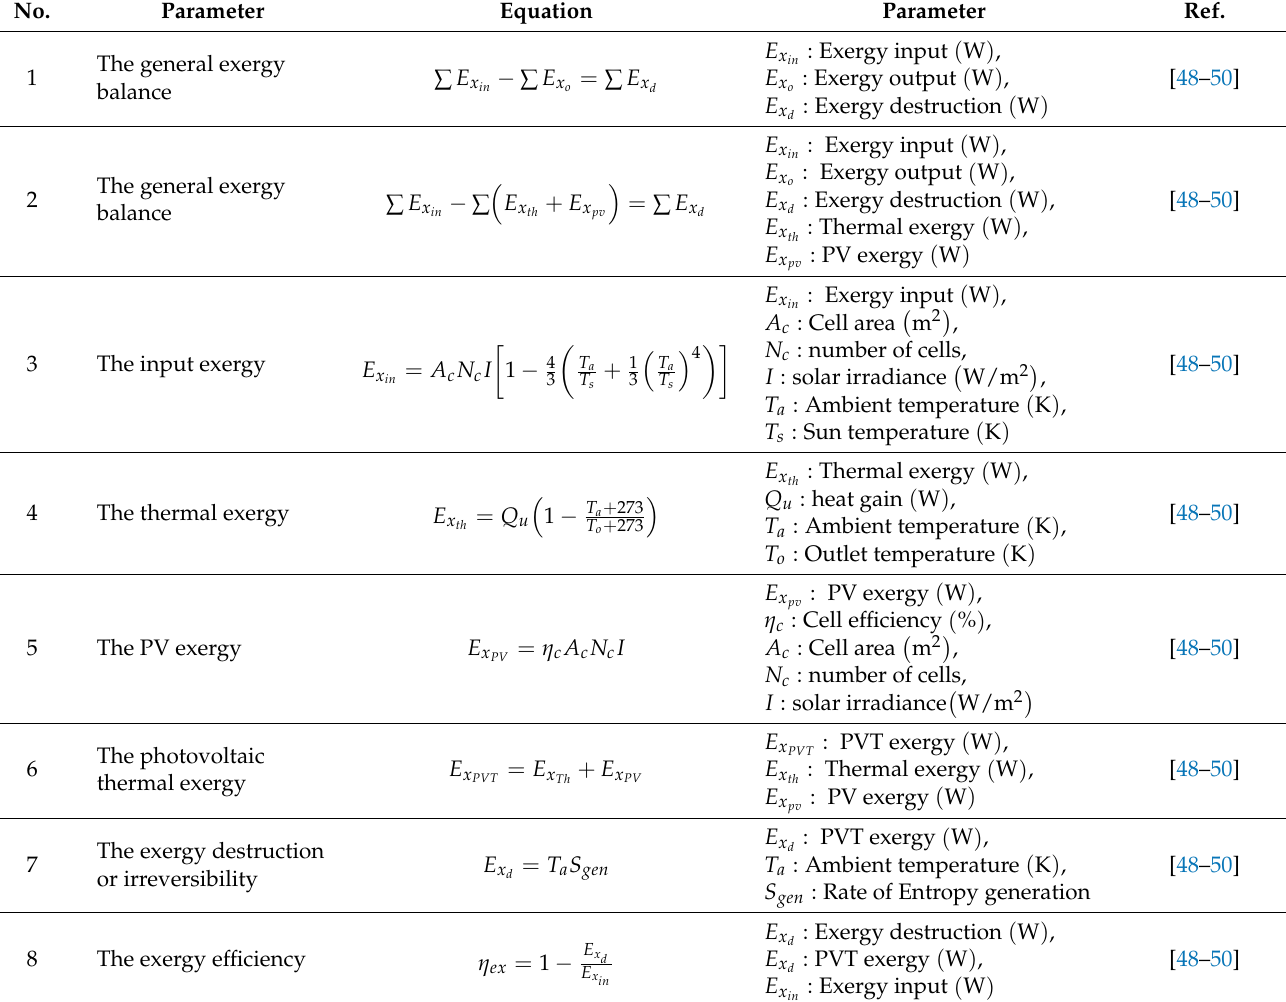
Table 6. Exergy analysis